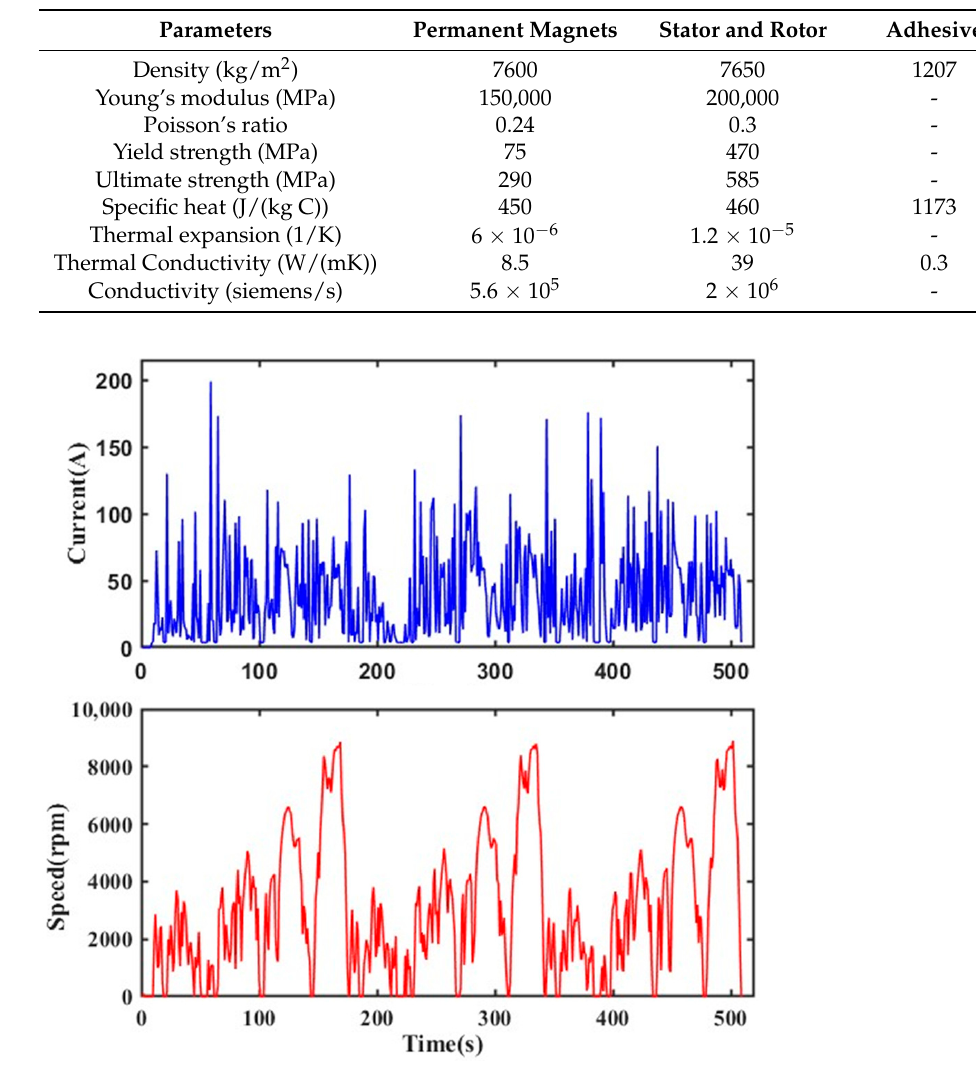
Figure 3. Current and speed time